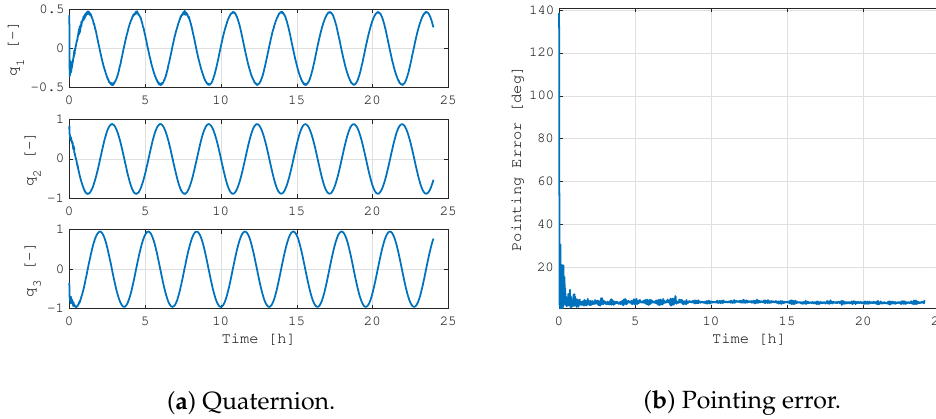
Figure 9. MIL simulation of nadir-pointing